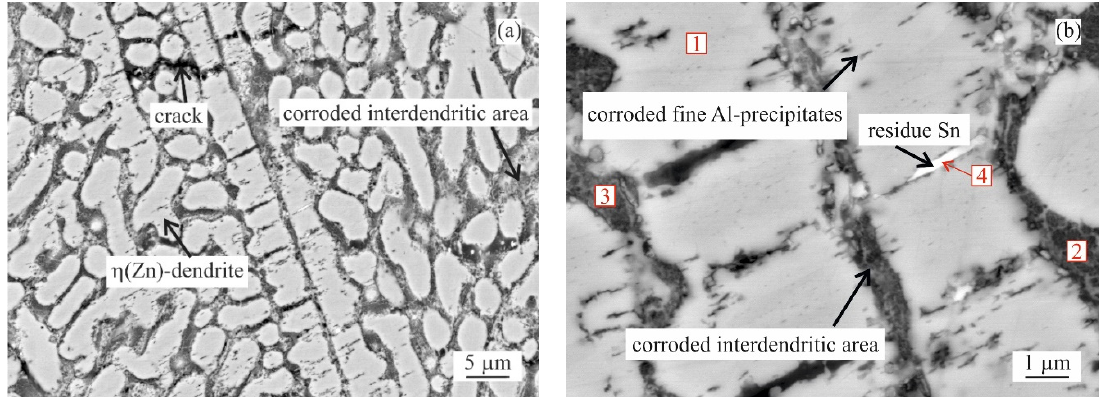
Figure 8. MZ + 2.0Sn as-cast microstructure after 1000 h in NSST affected by IG corrosion: ( a ) overview, ( b ) detail.